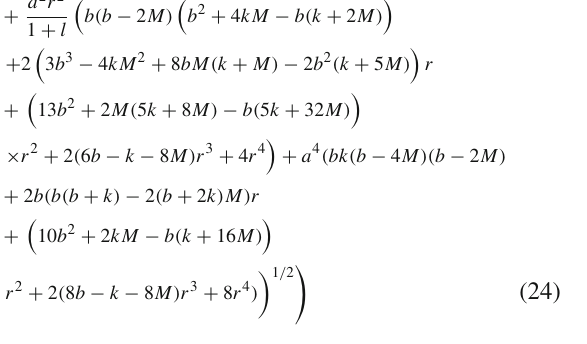
Fig. 4 The figure of the shadows for different values of b when θ = π